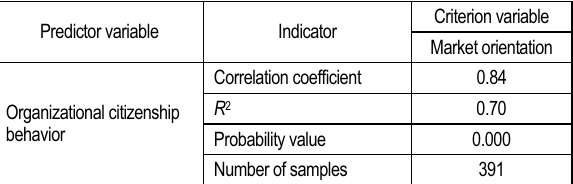
Criterionvariable